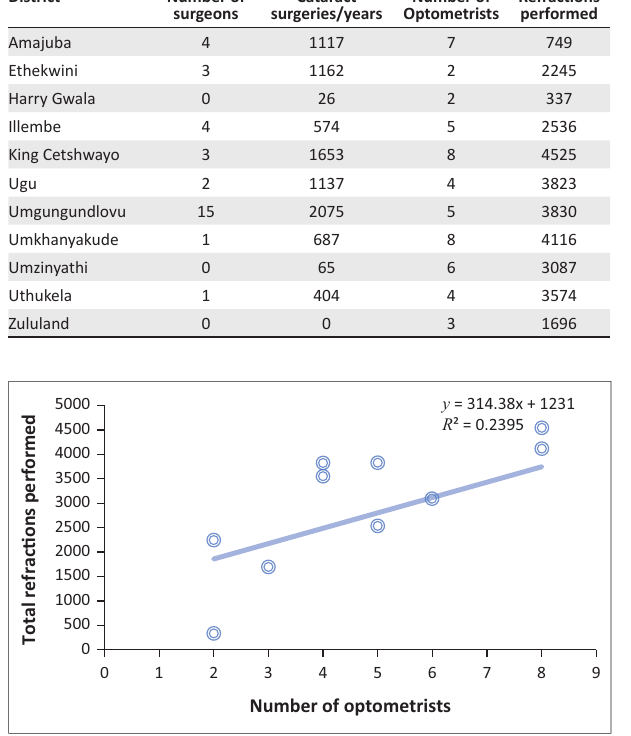
TABLE 3: A breakdown of cataract surgeries and refractions performed. District Number of surgeons